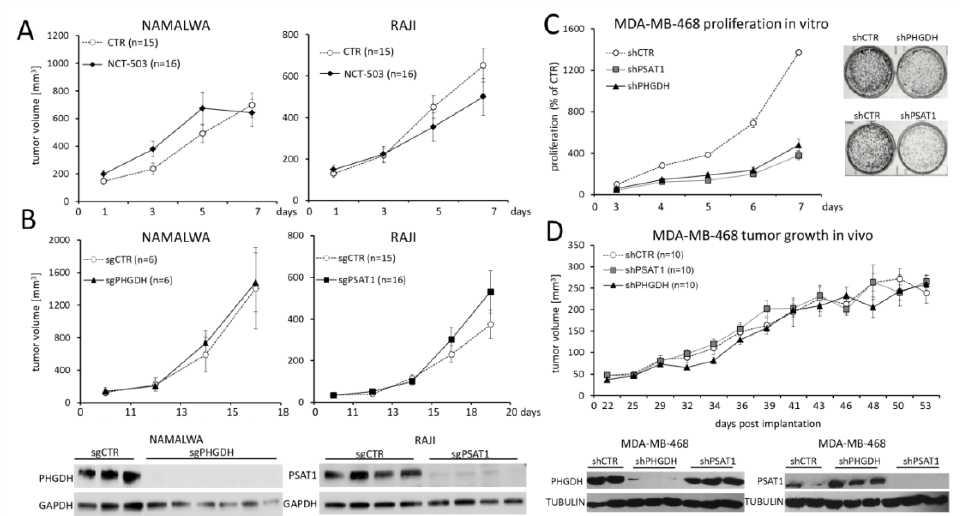
Figure 6. Inhibition of SBP in vivo does not affect the growth of NAMALWA and RAJI tumors. ( A ) Xenograft growth kinetics in mice inoculated with RAJI or NAMALWA cells and treated with NCT-503 or NCT-503 inactive control (CTR), each at a dose of 40 mg / kg / day intraperitoneally. ( B ) The effect of PHGDH (left) and PSAT1 (right) genetic knockout on the xenograft growth. ( C ) Genetic PHGDH and PSAT1 knockdown with shRNA impairs MDA-MB-468 breast cancer cell line proliferation and clonogenicity in serine-deficient medium in vitro (upper). The graph in ( C ) shows means ± SD from two independent experiments performed in triplicates. **** p < 0.0001 for shCTR vs. shPSAT1 and shCTR vs. shPHGDH for all analyzed days. Statistical analysis was performed using ANOVA. ( D ) PHGDH / PSAT1 knockdown does not impact the growth of MDA-MB-468 xenografts in vivo. Graphs in ( A , B , D ) represent means ± standard errors of the means; “ n ” refers to the number of mice in each experimental group. Decreased expression of PHGDH and PSAT1 in BL and MDA-MB-468 xenografts was confirmed by immunoblotting; representative cases from each experimental group are shown.